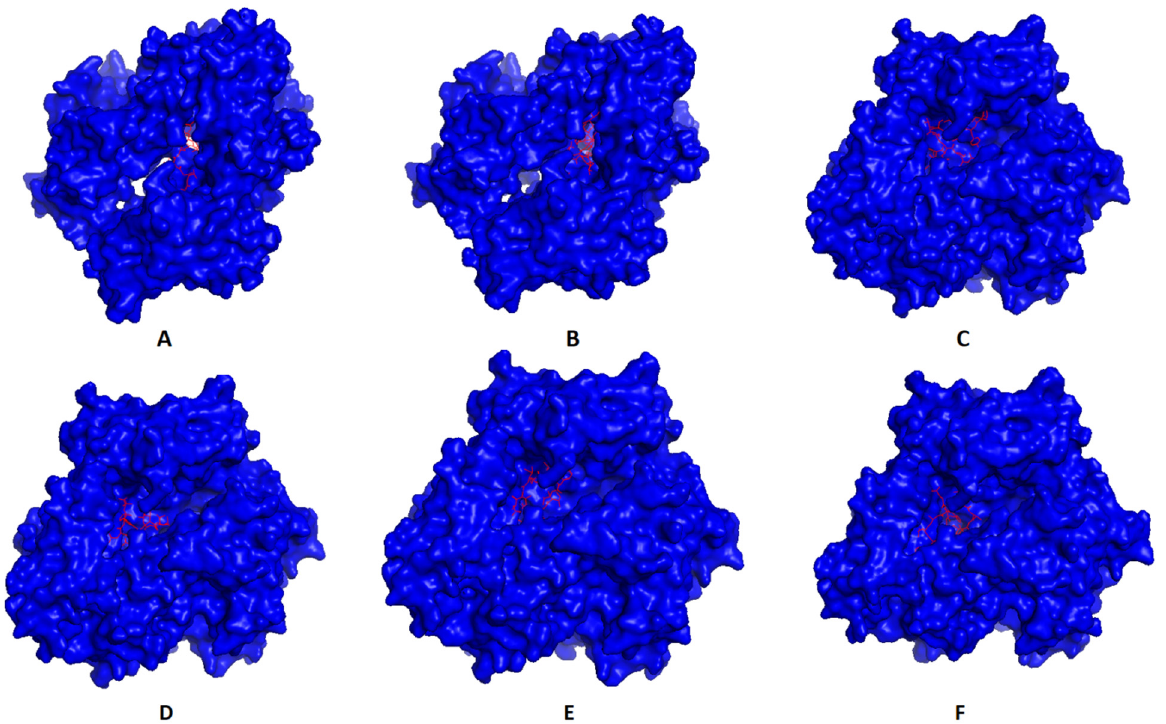
Figure 3. Predicted positions of MHC-I peptides (red color) in the 3D structure of HLA-A*11:01 receptor (blue color), structures ( A – F ) are for epitopes number 1,2,3,4,5, and 6, respectively, from Table 5.